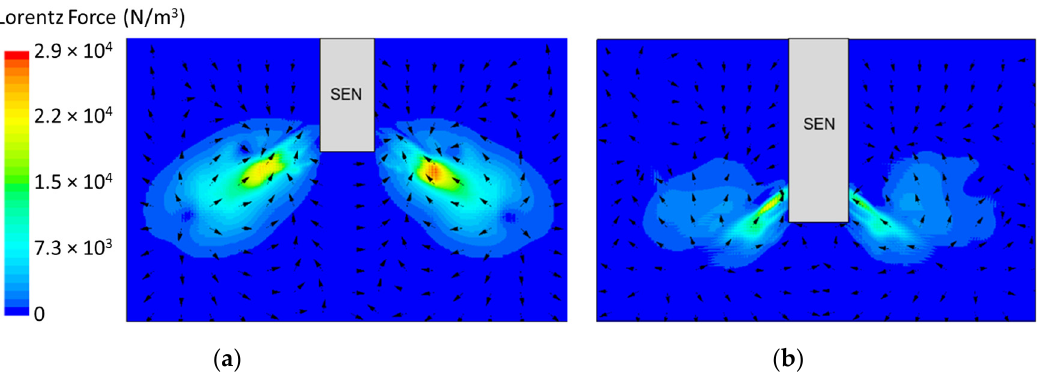
Figure 12. ( a ) Low SEN depth 110 mm (Case 4) vs. ( b ) high SEN depth 350 mm (Case 8) flow streamline.